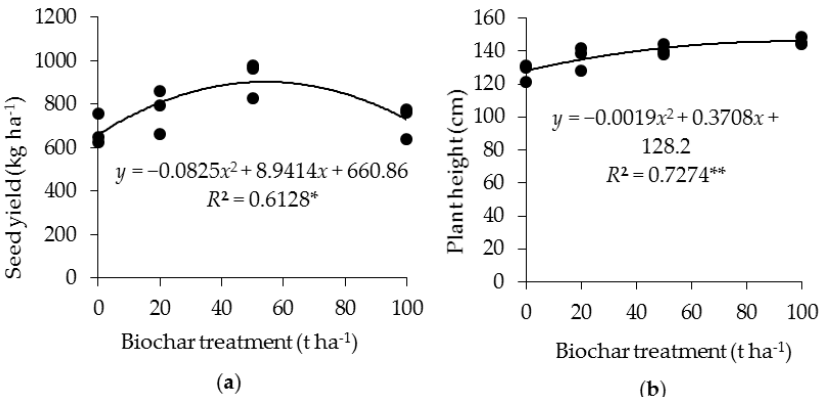
Figure 2. ( a ) The seed yield; ( b ) plant height response to rice husk biochar treatments.